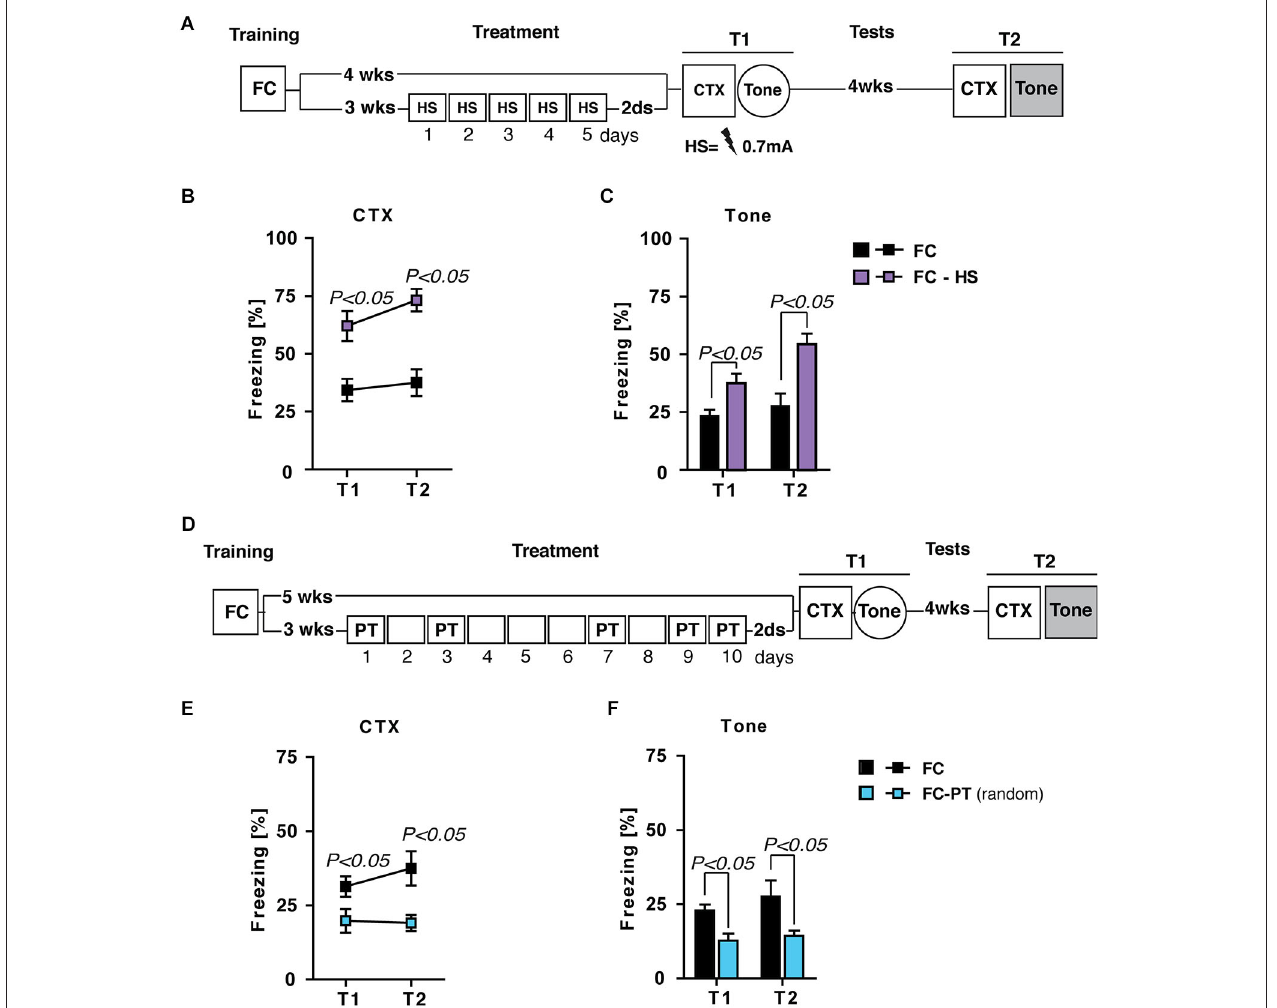
fear sensitization (Tone) 5 (T1) and 9 (T2) weeks after training. FC-PT (random) , fear-conditioned mice ( n = 7) exposed to PT treatment (10 days) with a random PT administration (on day 1,3,7,9,10) 3 weeks after training and then submitted to CTX and Tone at T1 and T2. ( E ) Freezing (%) in the CTX recorded at T1 and 4 weeks later at T2. The results indicated that PT treatment with a random footshock administration decreased fear in the contextual memory test. ( F ) Freezing (%) in response to a neutral tone (Tone) recorded at T1 and T2. Results indicated that PT treatment with a random footshock administration was able to persistently reduce fear sensitization. Data are expressed as mean + SEM. Results of individual post hoc comparisons (Duncan’s tests and Fisher’s tests) are depicted in the figure [n.s., not significant = P >